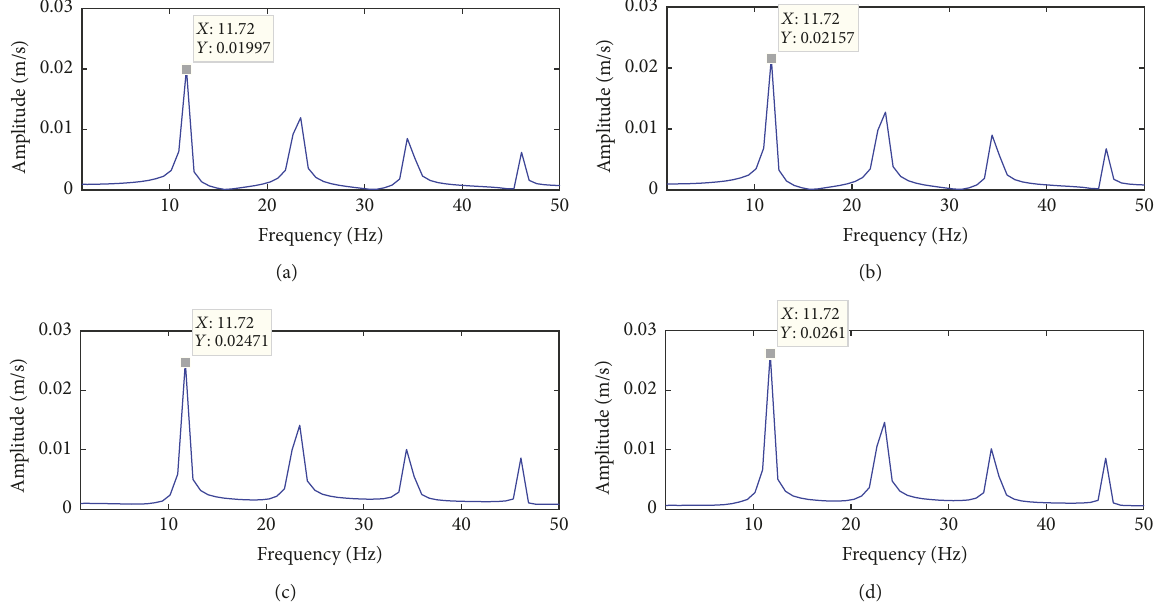
Figure 15: The spectra of velocities of the balls in the radial direction in the defect area under different loads: (a) 4.9 N, (b) 9.8 N, (c) 14.7 N, and (d) 19.6